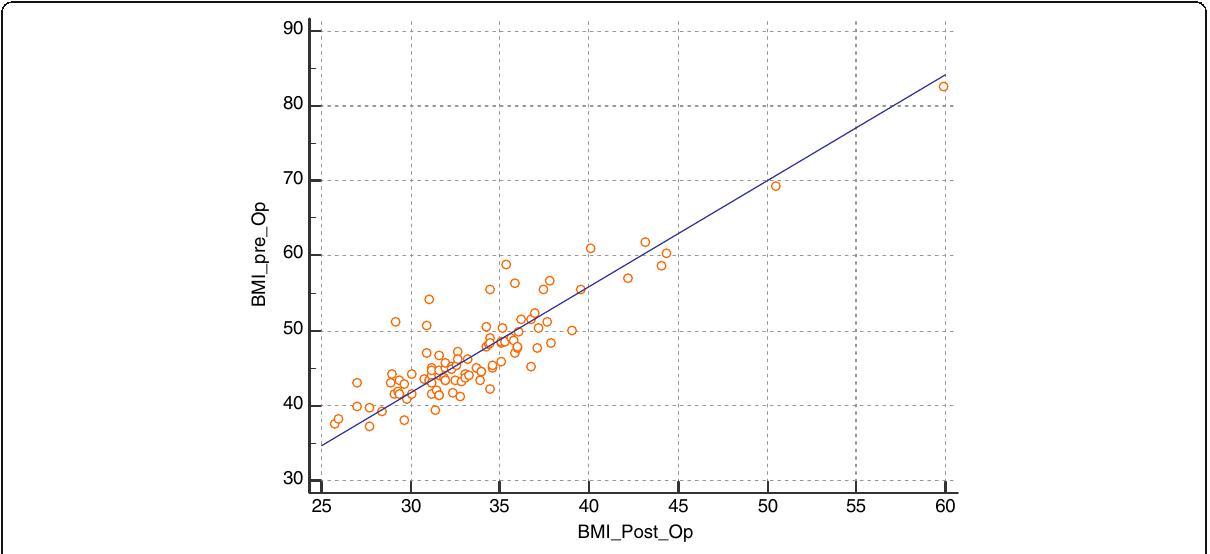
Fig. 2 Correlation between postoperative BMI and preoperative